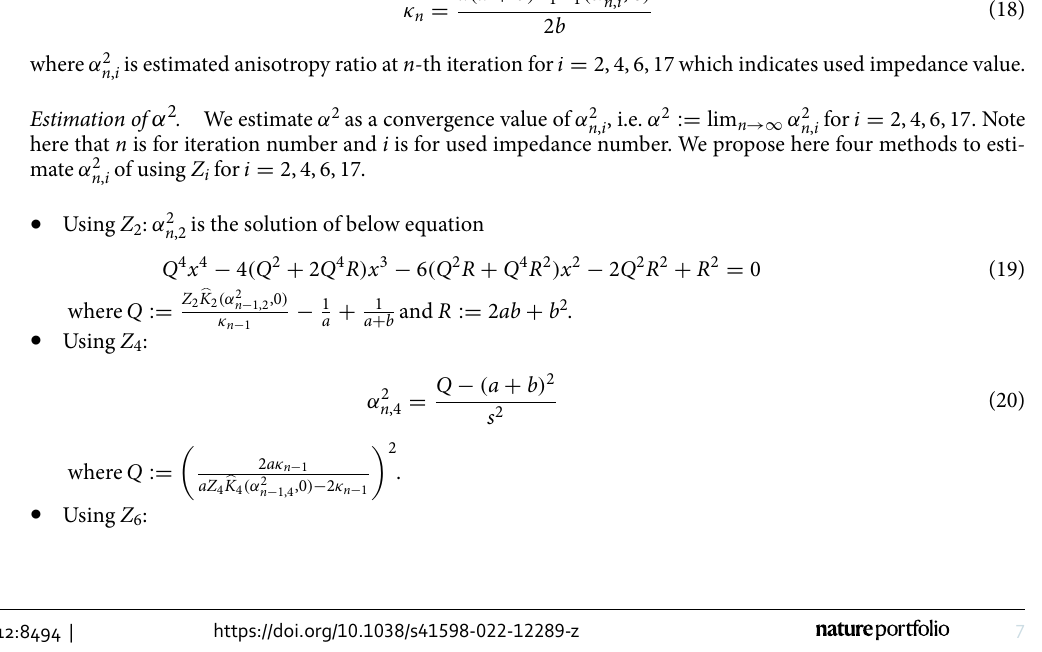
Z Z i 0 (or π/ 2 ), φ 0 , ϕ 2, 4, 6, 17 0 for i Inverse Method I: are measured in θ . 1 and } = = ∈ { = Assumption 1. The major muscle fibers orientation is known and the needle axis is aligned on the z -axis (i.e., the needle is inserted perpendicularly to the muscle fibers). Method I uses four electrodes on a plane parallel to the direction of the muscle fibre (e.g. [ES] plane in Fig. 1). 2, 4, 6, 17 as in Fig. 4. The measured Z 1 is On the selected plane, we measure two impedances Z 1 and Z i for i = κ and measured Z i is used to compute α 2 . The flowchart can be seen in Fig. 5. used to compute ¯